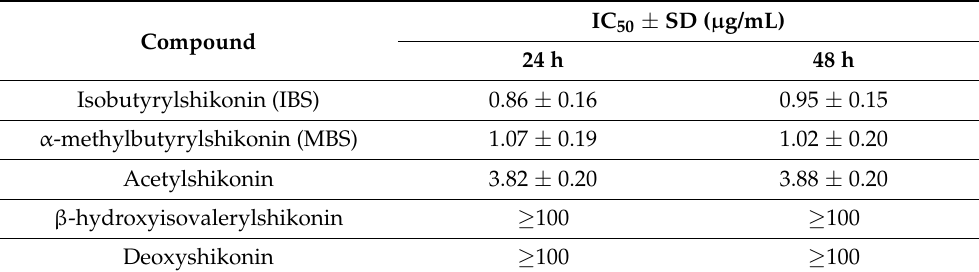
Table 2. The IC50 values of shikonins determined by MTT assay on BCL1 cell line.